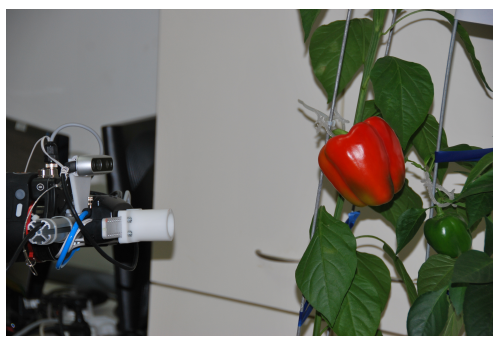
Figure 3. Camera mounted on robotic arm acquiring images of red sweet pepper mounted on a pepper plant.